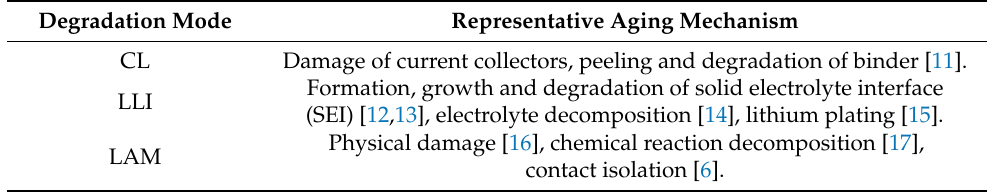
Table 1. The representative aging mechanisms included in the three degradation modes. Degradation Mode Representative Aging Mechanism CL Damage of current collectors, peeling and degradation of binder [11]. Formation, growth and degradation of solid electrolyte interface LLI Physical damage [16], chemical reaction decomposition [17], LAM contact isolation